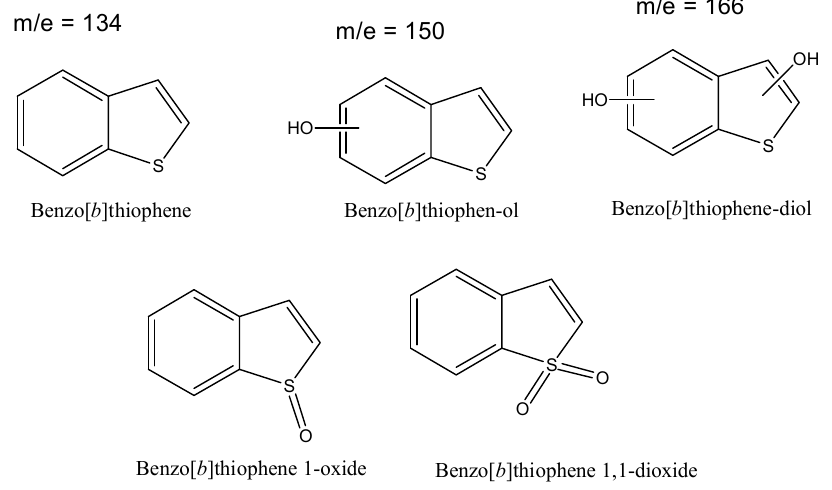
Figure 7. Main products obtain during sonochemical degradation of BT.